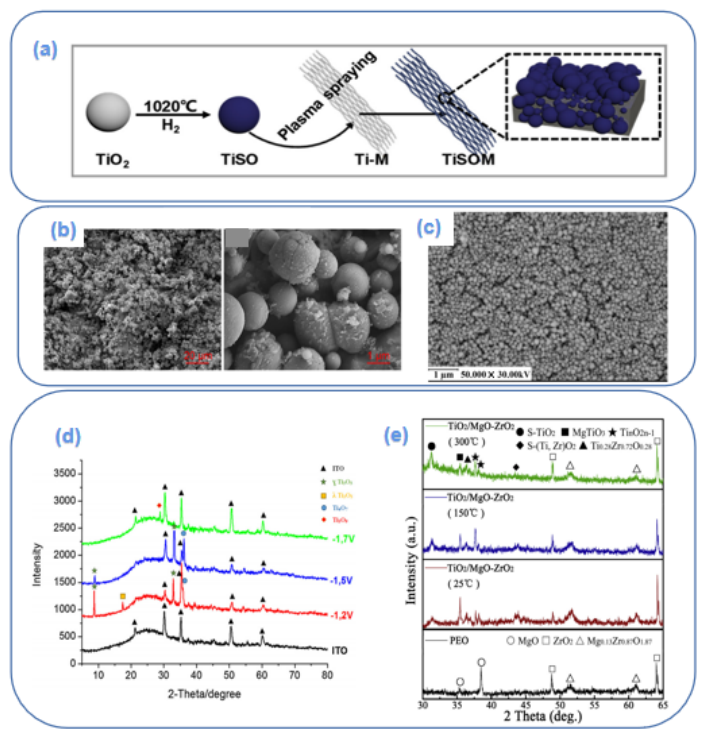
Figure 3. Processes of plasma spraying technology [76] ( a ); SEM images of coating electrode [76] ( b ); SEM images of electrodeposition electrode [82] ( c ); XRD pattern of electrodeposition electrode [82] ( d ); XRD pattern of magnetron sputtering electrode [81] ( e ).